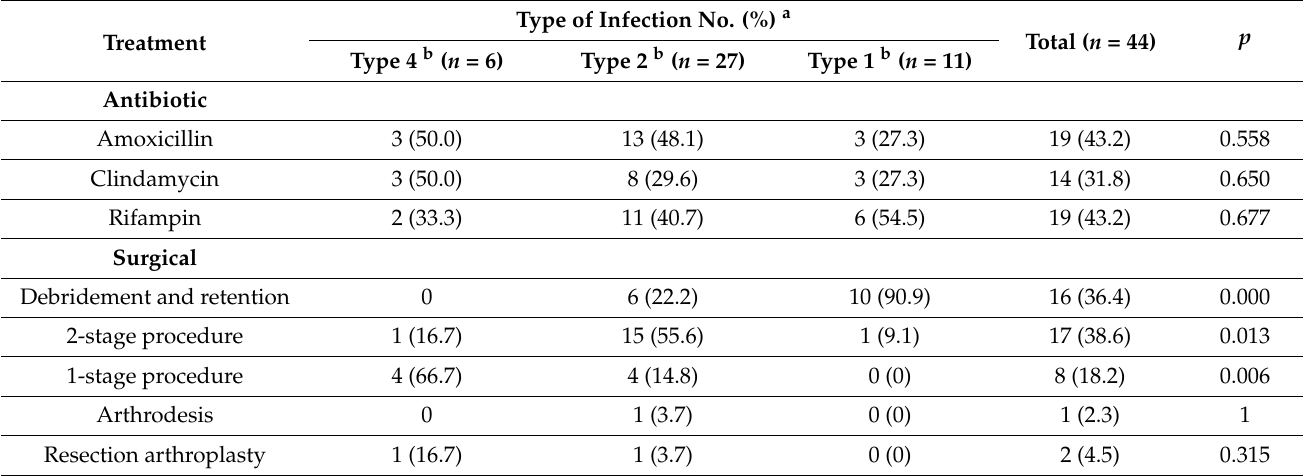
Table 3. Comparison between the types of treatment with type of infection of shoulder PJI due to C.